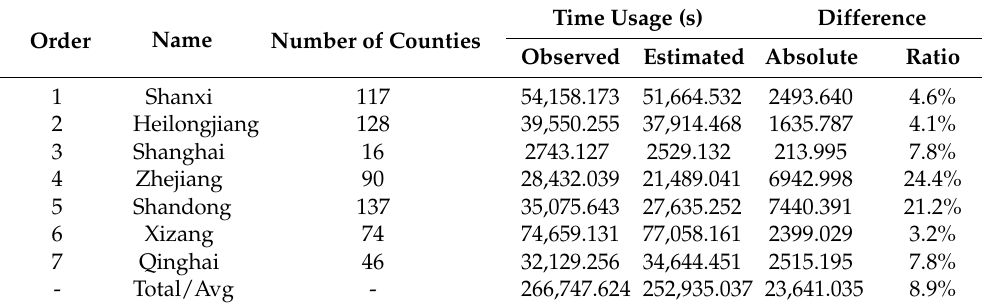
Table 4. Comparison of the observed time and estimated time.